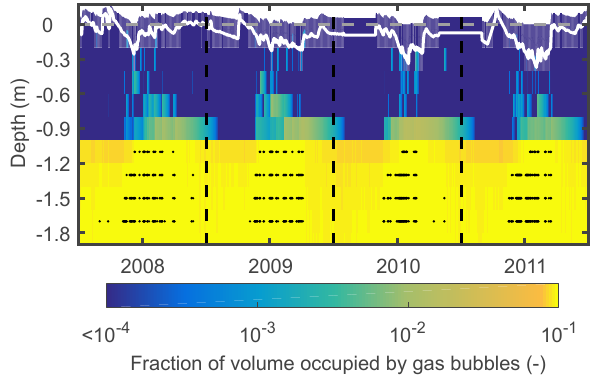
Figure 3. Bubble volume profiles calculated with the EBG ap- proach. Black dots highlight periods and depths with ebullition events. The white line shows the water table